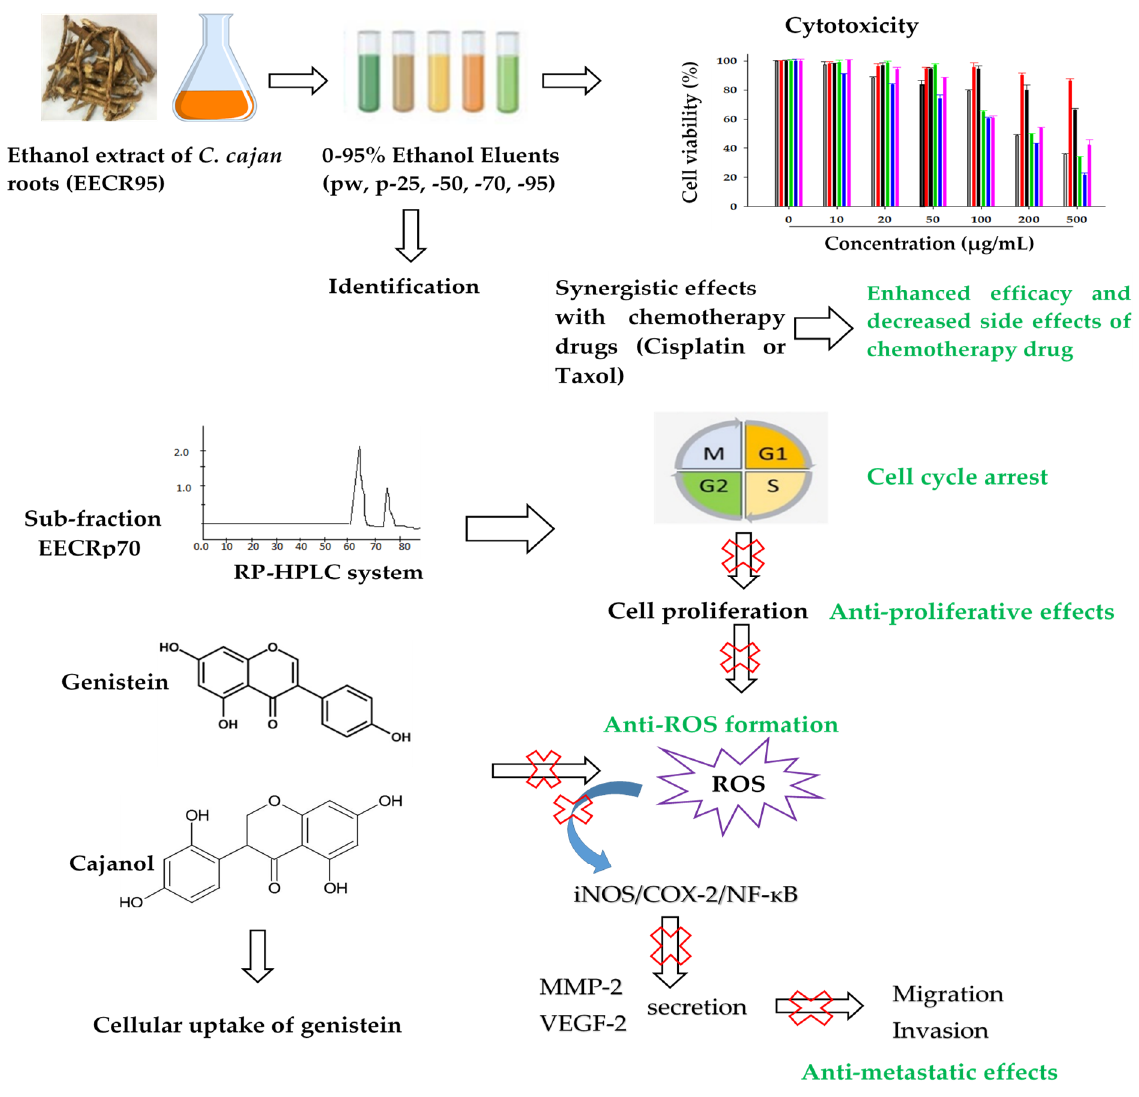
Figure 11. Schematic summaries of the anti-proliferative and anti-metastasis effects of EECRp70 on SCC25 cells. Crude 95% ethanol extract from C. Cajan roots (EECR95) was fractionated (pw, p25–95). The strongest fraction was selected for cytotoxicity and identification of bioactive compounds using RP-HPLC systems. Two kinds of flavonoids (genistein and cajanol) were found high in sub-fraction EECRp70, which showed beneficial effects. In addition, EECRp70 synergized with chemotherapeutic agents, reduced cell proliferation, inhibited cell metastatic effects, caused cell apoptosis, and finally cancer cell death; cellular uptake of genistein could cause the EECRp70 proliferative and metastatic effects of oral squamous cell carcinoma